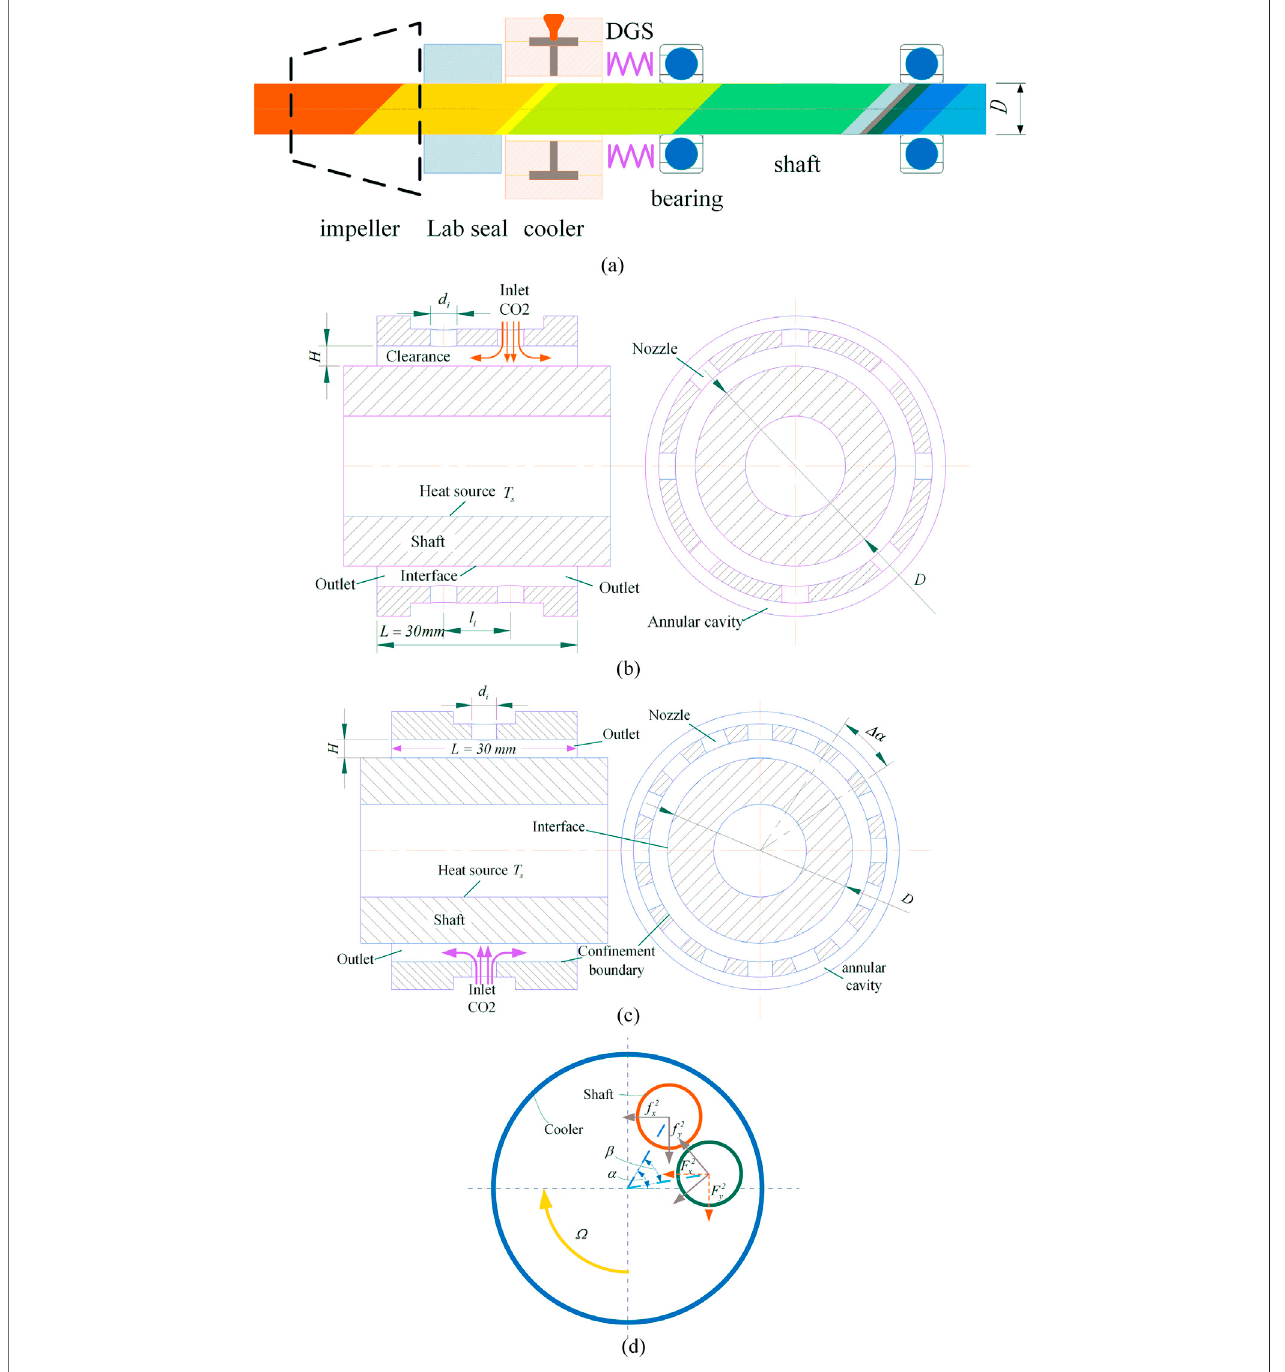
FIGURE1| Working mechanismoftheproposed cooler andshaftingforSCO2 turbine. (A) Schematicdiagramofbearing-rotor system. (B) doublerow. (C) single row. (D) Schematic graph of rotating frame with cooler describing a journal with amplitude e and attitude angle α . Stationary coordinate ( X, Y ) and its rotation angle β are